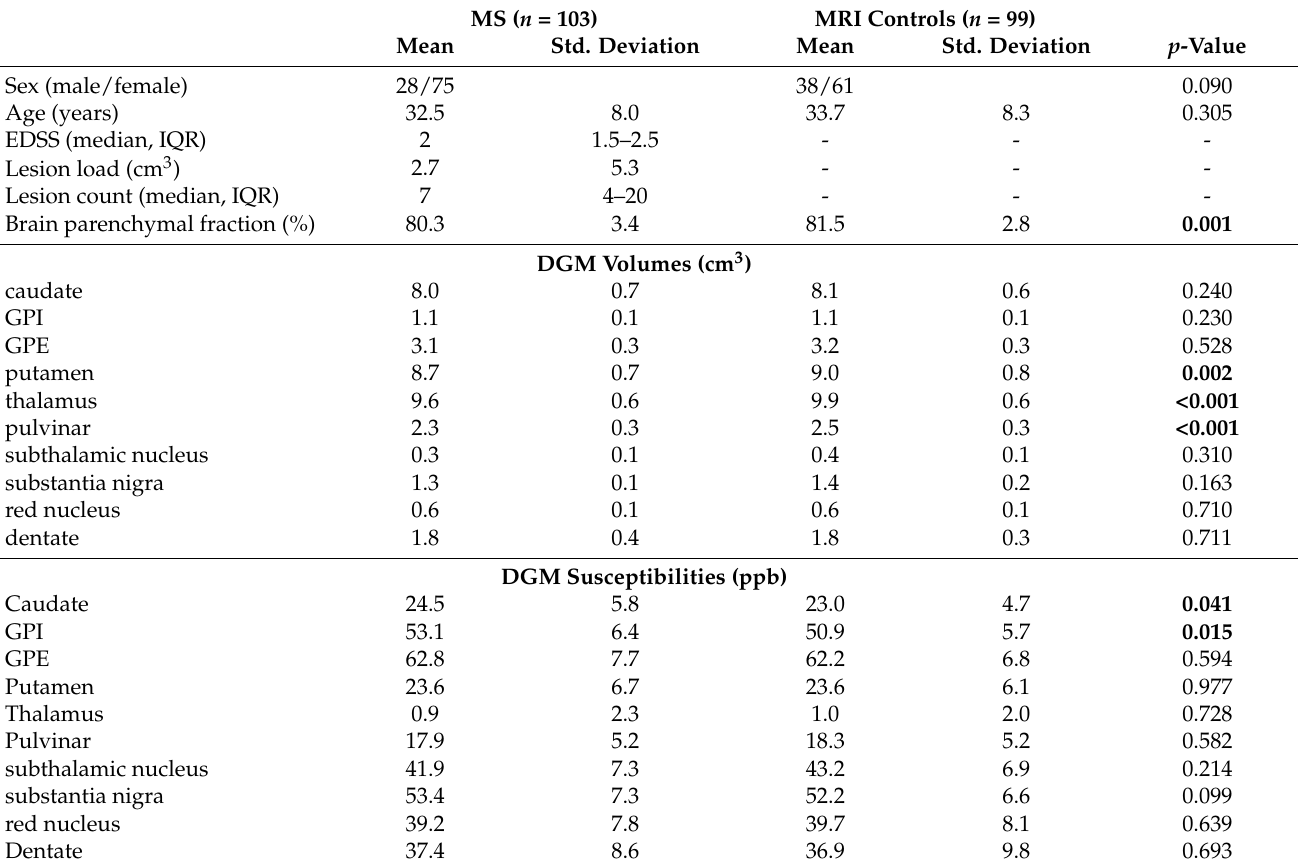
Table 1. Comparison of DGM volumes and susceptibilities in MS patients and controls.